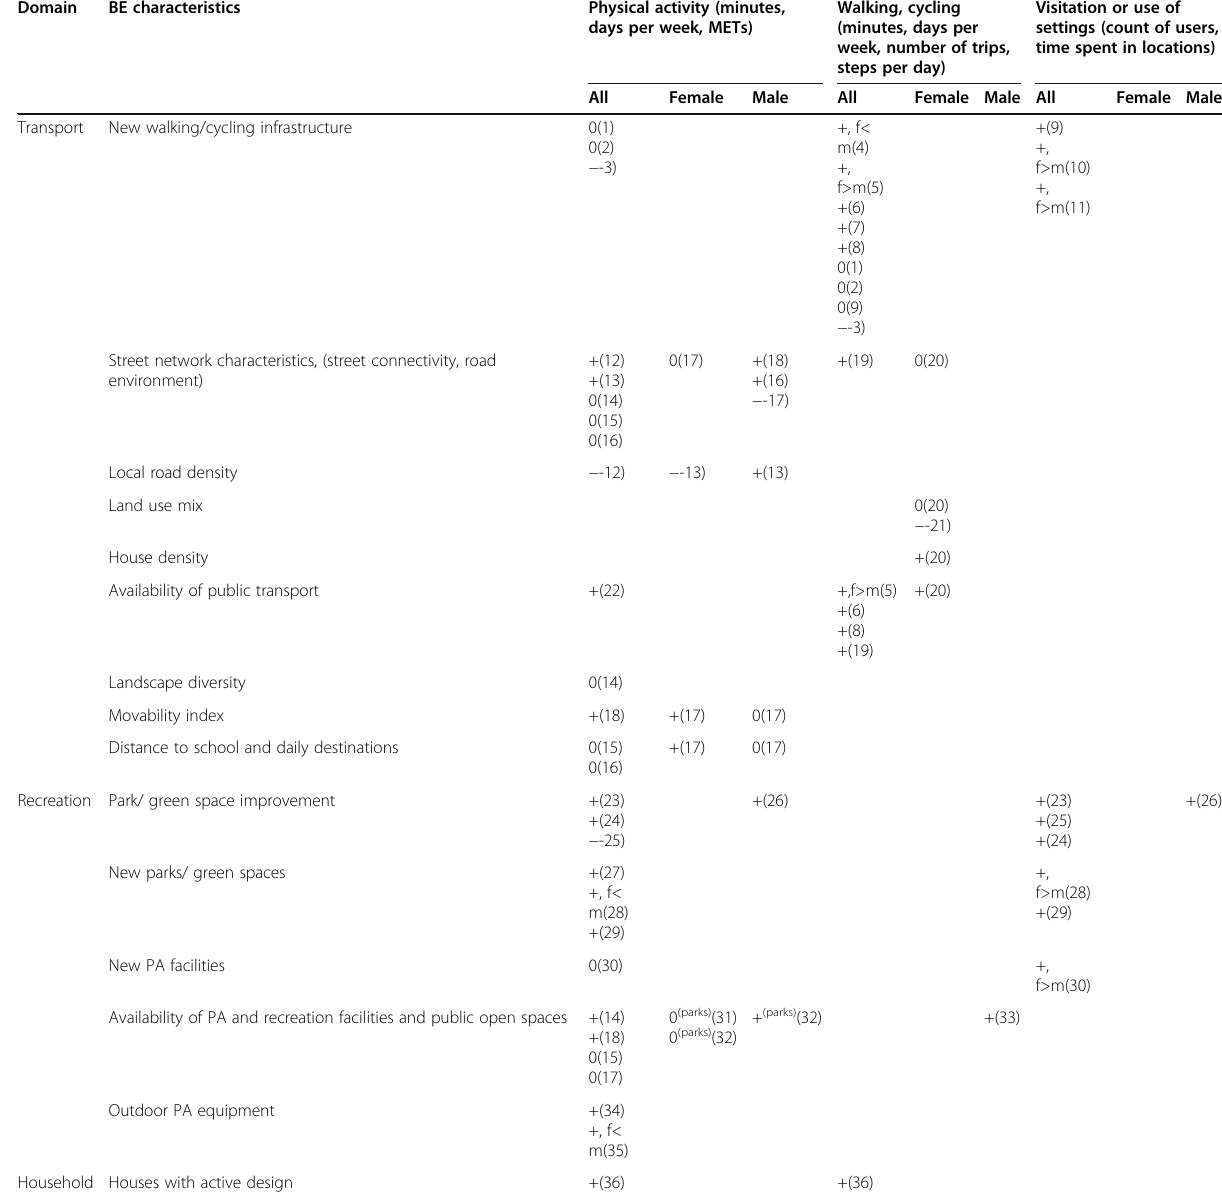
Table 2 Key findings for impact of built environment on PA behavior Domain